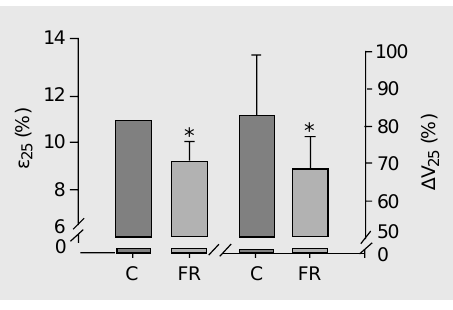
Figure 1. Ratio of left ventricular wall thickness (LVWT) to dia- stolic diameter (LVDD) and ratio of left ventricular weight (LVW) to volume (V0). Data are re- ported as means ± SD for 9 ani- mals in each group. C = control group; FR = food-restricted group. Note that both ordinates and abscissa are discontinuous. *P < 0.05 compared to control animals (Student t -test).